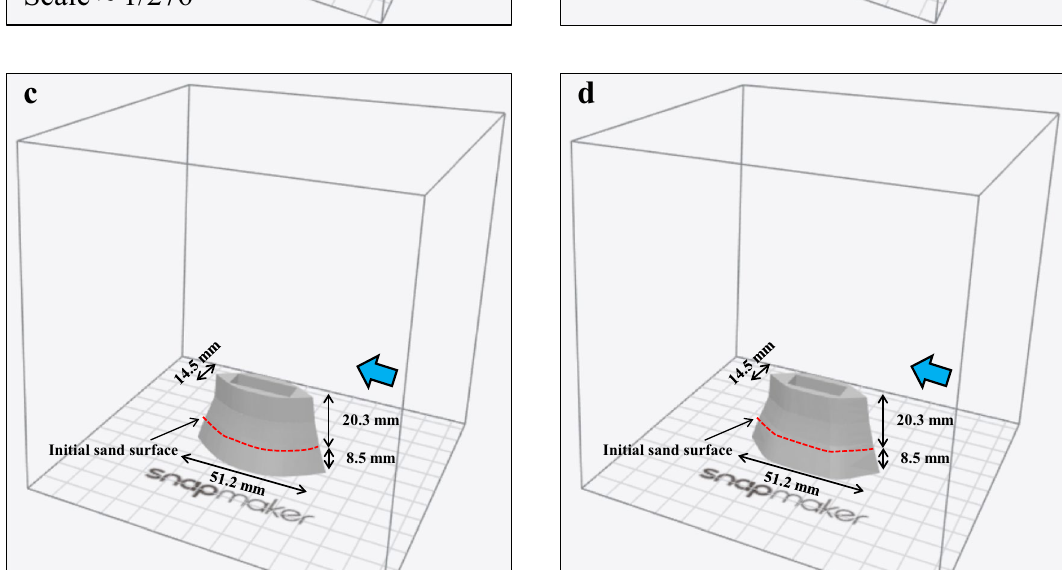
Initial sand surface (Top surface of base plate)